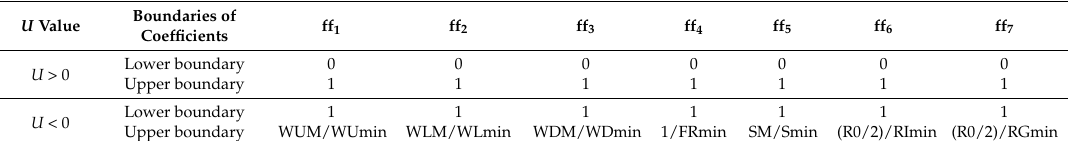
Table 5. The boundaries of the coefficients of state